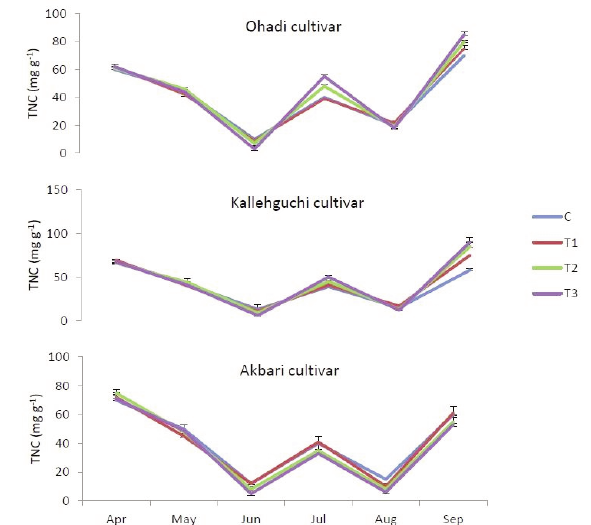
Fig. 3 - Interaction of stage of brassinostroides application and cultivar on annual changes in total non-structural carbohydrate (TCN) concentration of one-year-old wood of pistachio in the “on” year. C= Control, T1= Bud swelling phase, T2= two weeks after full bloom, T3= T1 and T2.